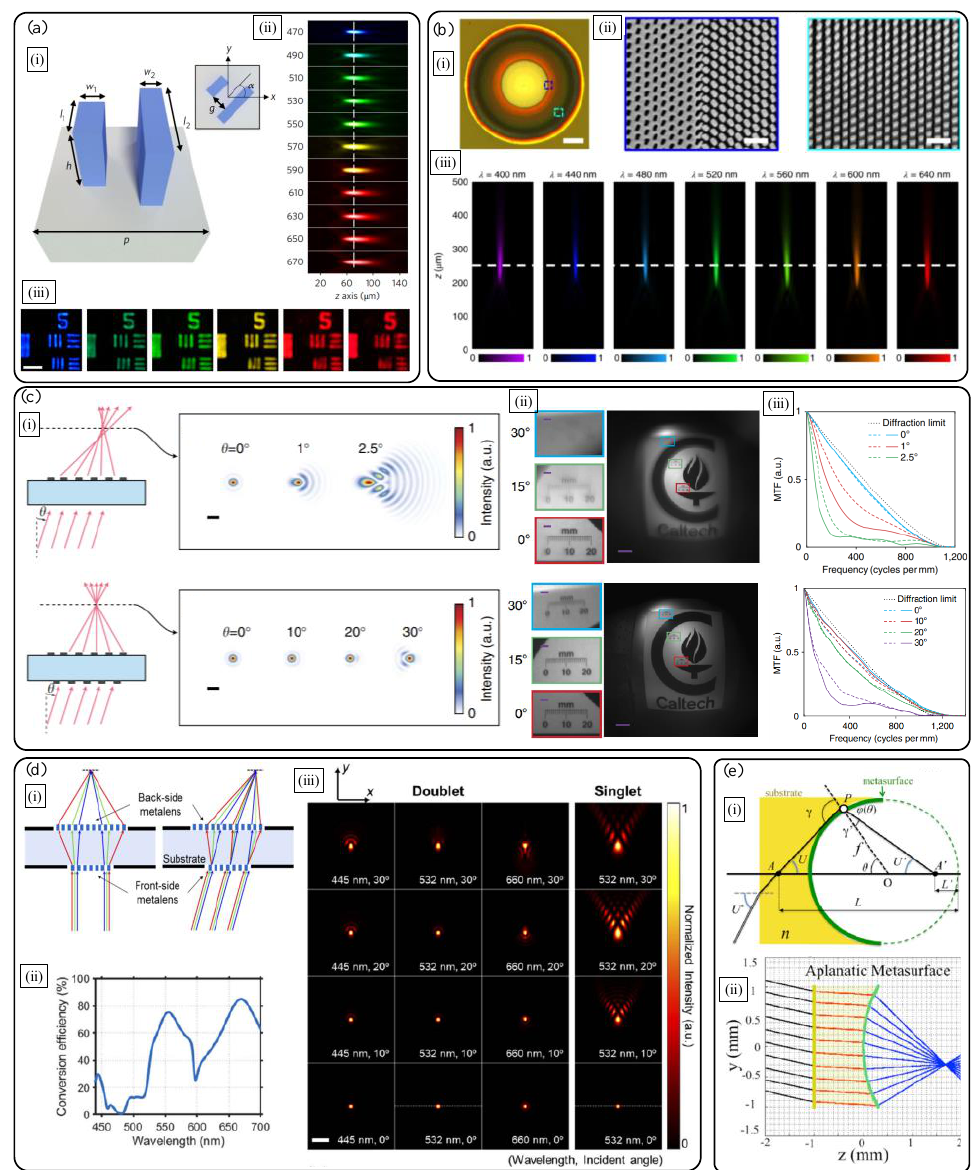
Figure 5. ( a ) Longitudinal chromatic aberration correction using anisotropic complex TiO 2 nanofin library [19]. ( i ) Nanoantenna schematic, measured broadband achromatic ( ii ) focusing and ( iii ) imaging performances. ( b ) Longitudinal chromatic aberration correction with GaN metalens [20]. ( i ) Optical image and ( ii ) magnified scanning electron micrographs. ( iii ) Measured broadband achromatic focusing property. ( c ) Monolithic doublet metalens with a-Si nanoposts for reducing monochromatic aberrations [25]. Comparison of singlet and doublet in terms of ( i ) focusing and ( ii ), ( iii ) object imaging properties. ( ii ) Captured sample images and corresponding ( iii ) modulation transfer functions for sagittal (dashed lines) and tangential (solid lines) ray directions. ( d ) Doublet silicon metalens optimization for simultaneous correction of chromatic and monochromatic aberrations at the three colors [26]. ( i ) Concept diagram, ( ii ) color filtering efficiency of the backside metalens, and ( iii ) optimized performance comparison. ( e ) Curved aplanatic metalens design method [27]. ( i ) Schematic and ( ii ) deterministic design without spherical aberration and coma. Reprinted with permission from ( a ) [19] Copyright 2018 Springer Nature, ( b ) [20] Copyright 2018 Springer Nature, and ( c ) [25] Copyright 2016 Springer Nature. Reprinted with permission from ( d ) [26] Copyright The Optical Society and ( e ) [27] Copyright The Optical Society. Through a similar approach, GaN nanopillar based broadband compensations of LCA were achieved by S. Wang et al. in 2018. Using GaN, focusing efficiency is a bit